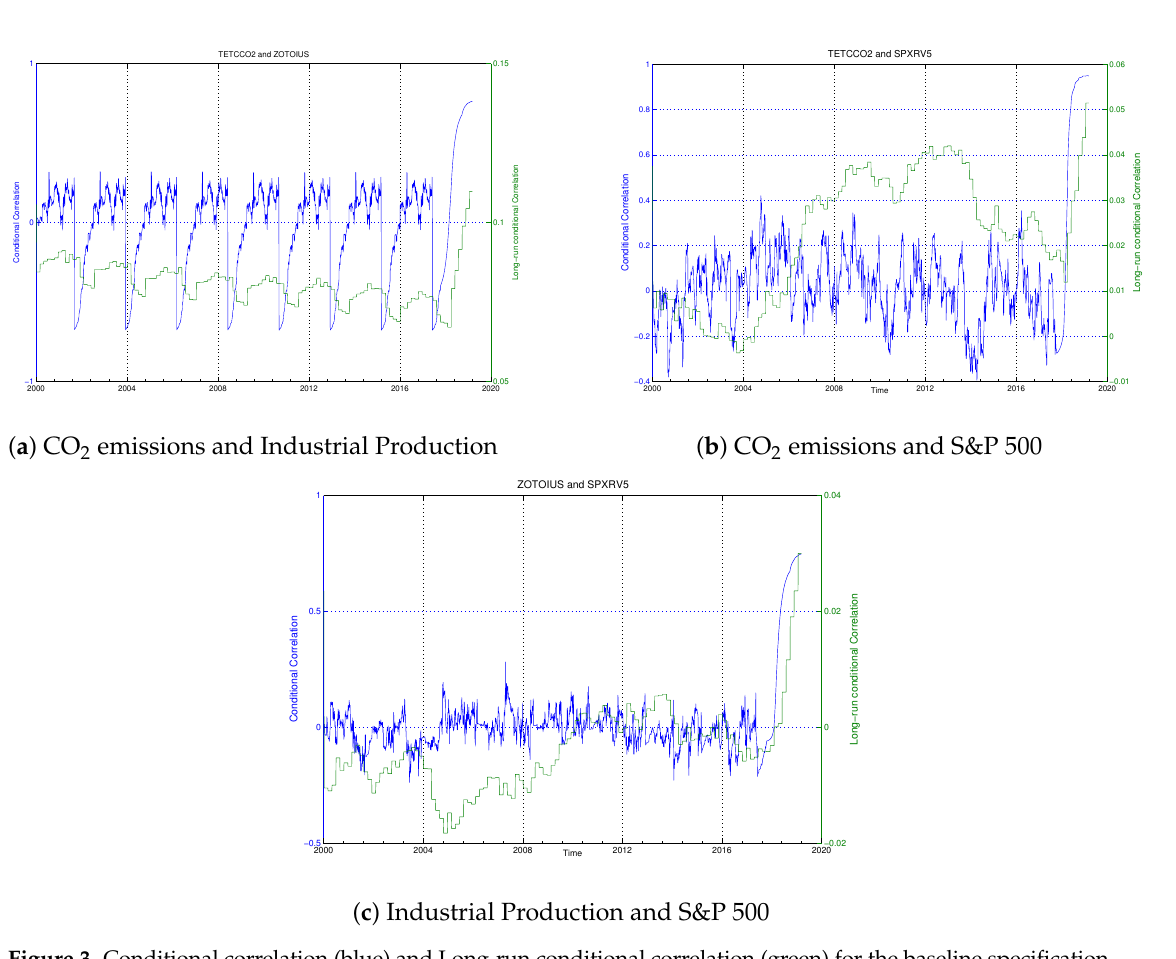
Figure 3. Conditional correlation (blue) and Long-run conditional correlation (green) for the baseline